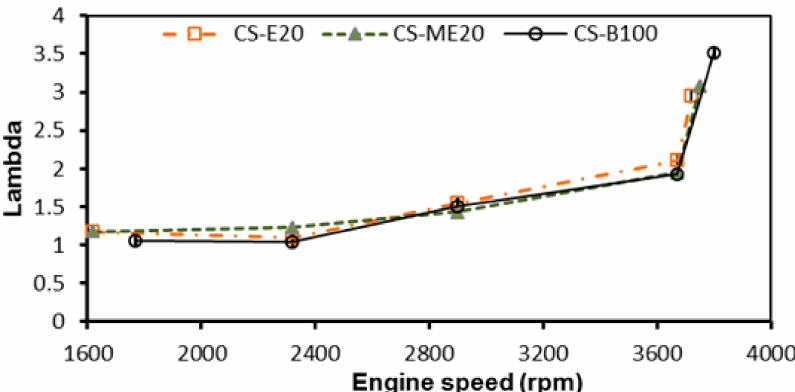
Figure 15. The relationship between engine speeds (rpm) and lambda for CS-B100, CSB-E20 and CSB-ME20.